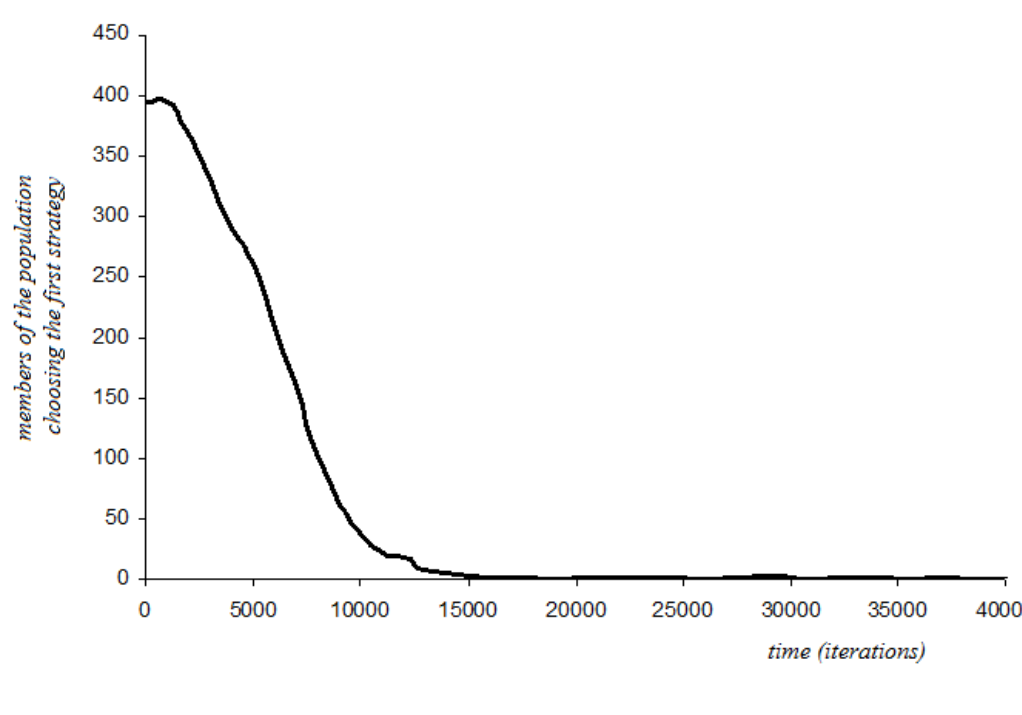
= 0.4, a = 0.15, b = 1. 0